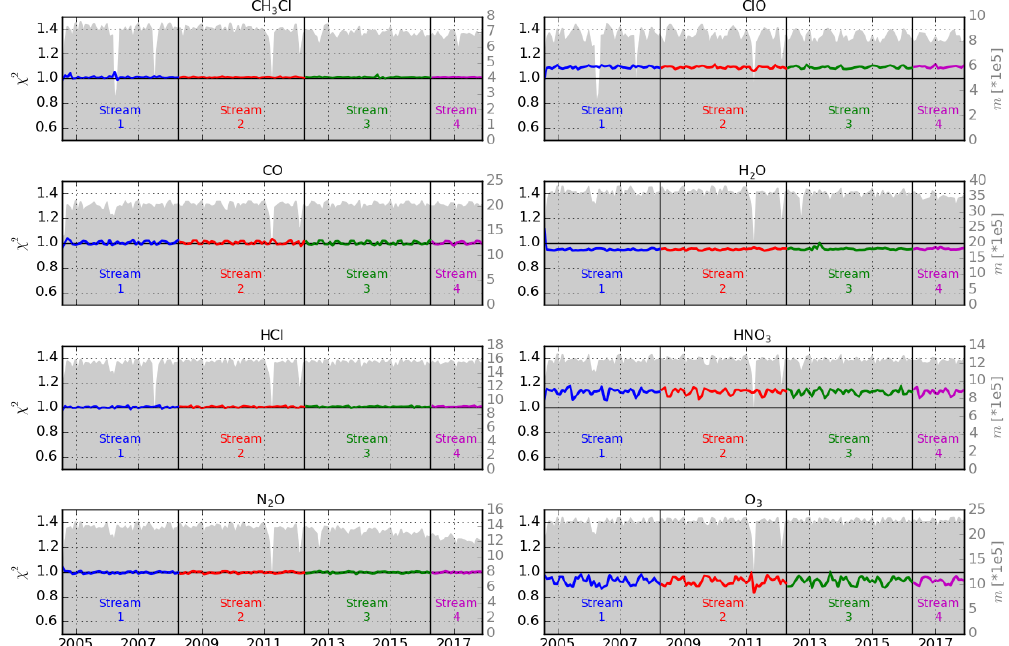
Figure 1. Time series of the monthly mean χ 2 for MLS assimilated species (coloured lines – one colour for each stream, left y axes) and the corresponding number of assimilated observations m (grey bars, right y axes). The horizontal black lines show the expected theoretical value of χ 2 = 1 and the vertical black lines show the dates of the transition between the different streams.